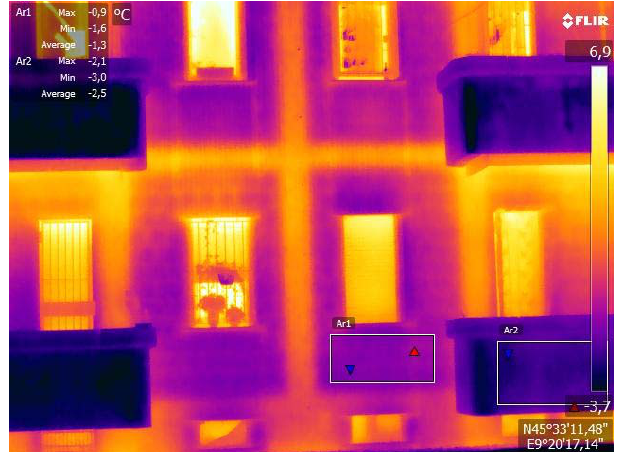
Figure 6. Graphic definition of the areas of the wall to evaluate the average temperatures to be considered